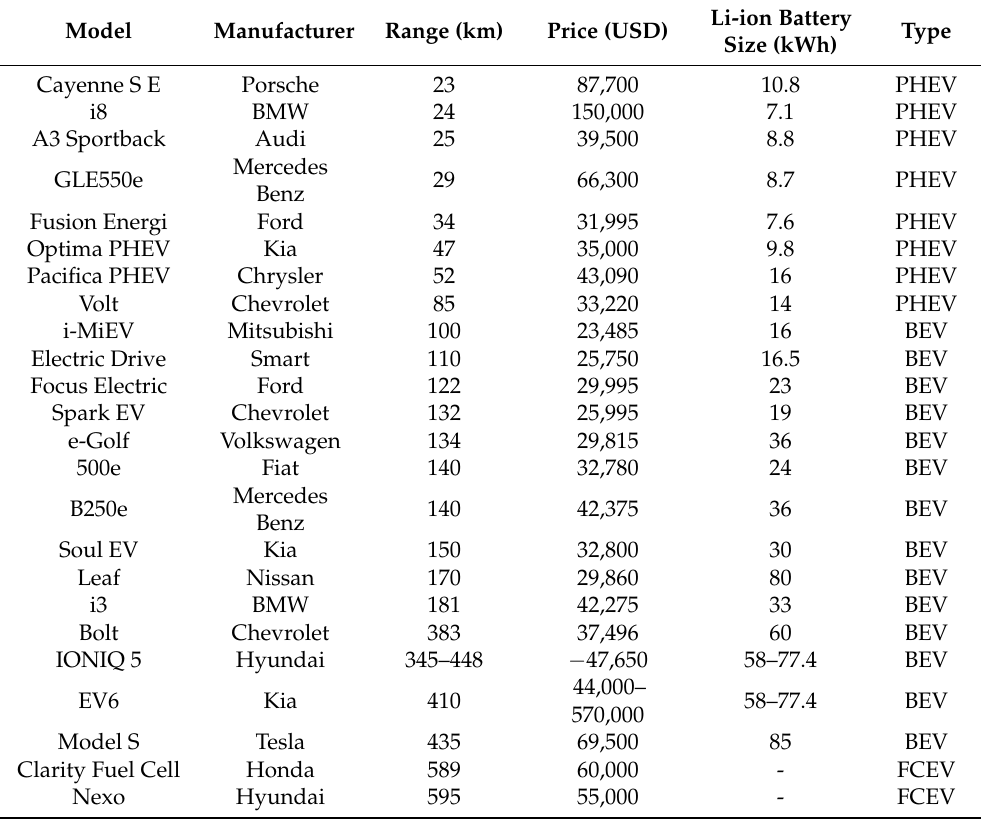
Table 1. Specifications of some electric vehicles (EV) available on the market